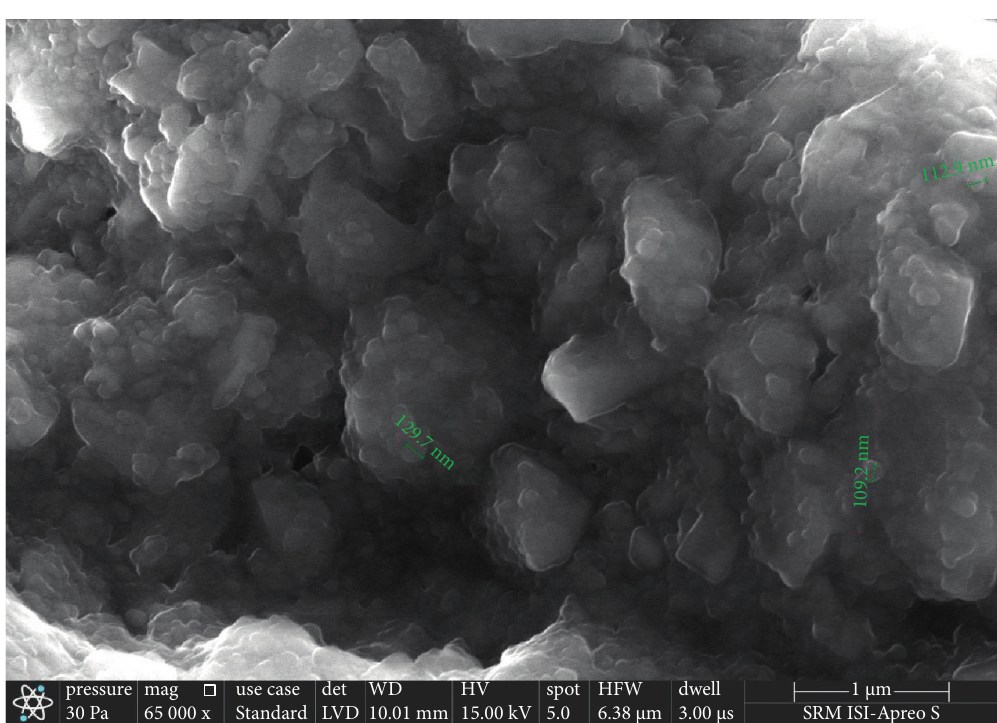
Figure 1: SEM image of experimental